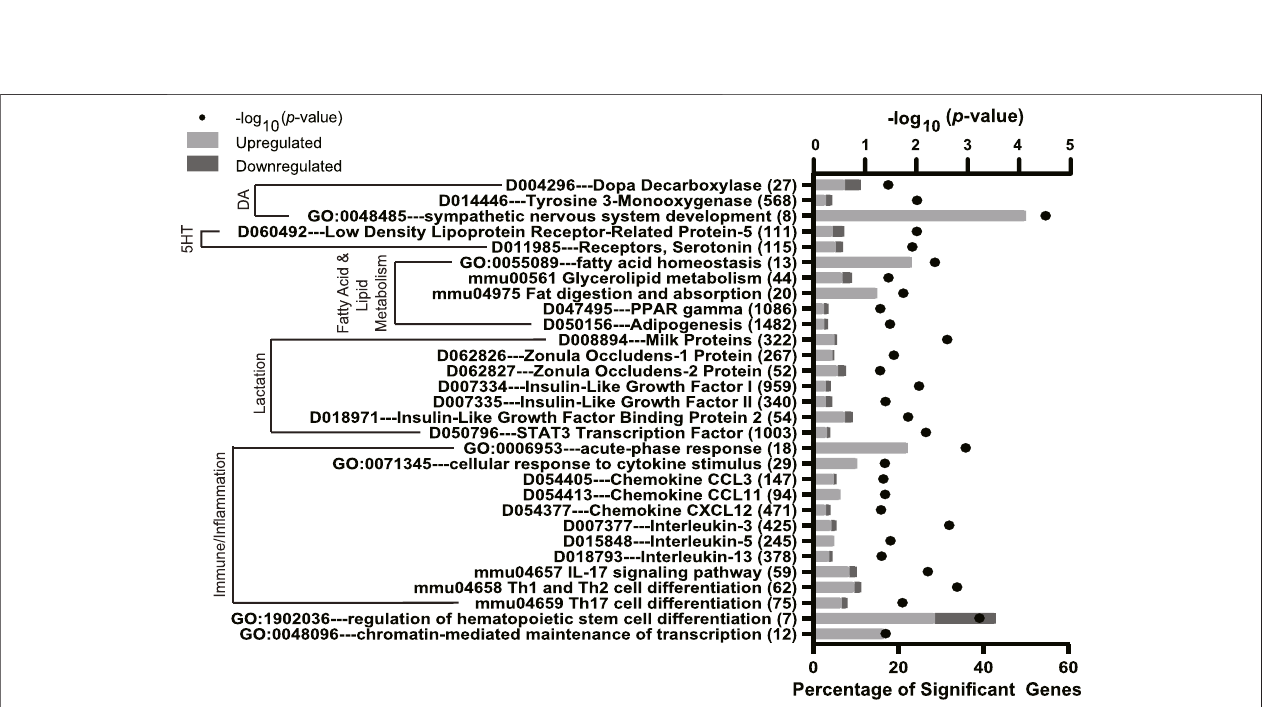
FIGURE 4 | Signi fi cantly enriched pathways from Gene Ontology (GO), Kyoto Encyclopedia of Genes and Genomes (KEGG), and Medical Subject headings (MeSH) pathway analysesinthemammaryglandofmice treatedwith fl uoxetine (20 mg/kg/d, n =8)or salinecontrol( n =8)fromembryonicday 13throughlactationday 10.They-axisdenotesthenamesandtotalnumberofgenesineachpathway,andthelowerx-axisdenotesthepercentageofsigni fi cantgeneswithineachpathway.The upper x-axis denotes the − log 10 p -value. Light gray bars indicate upregulated DEGs and dark gray bars indicate downregulated DEGs within each pathway. Abbreviations: DA, dopamine; 5HT, serotonin; IL, interleukin.